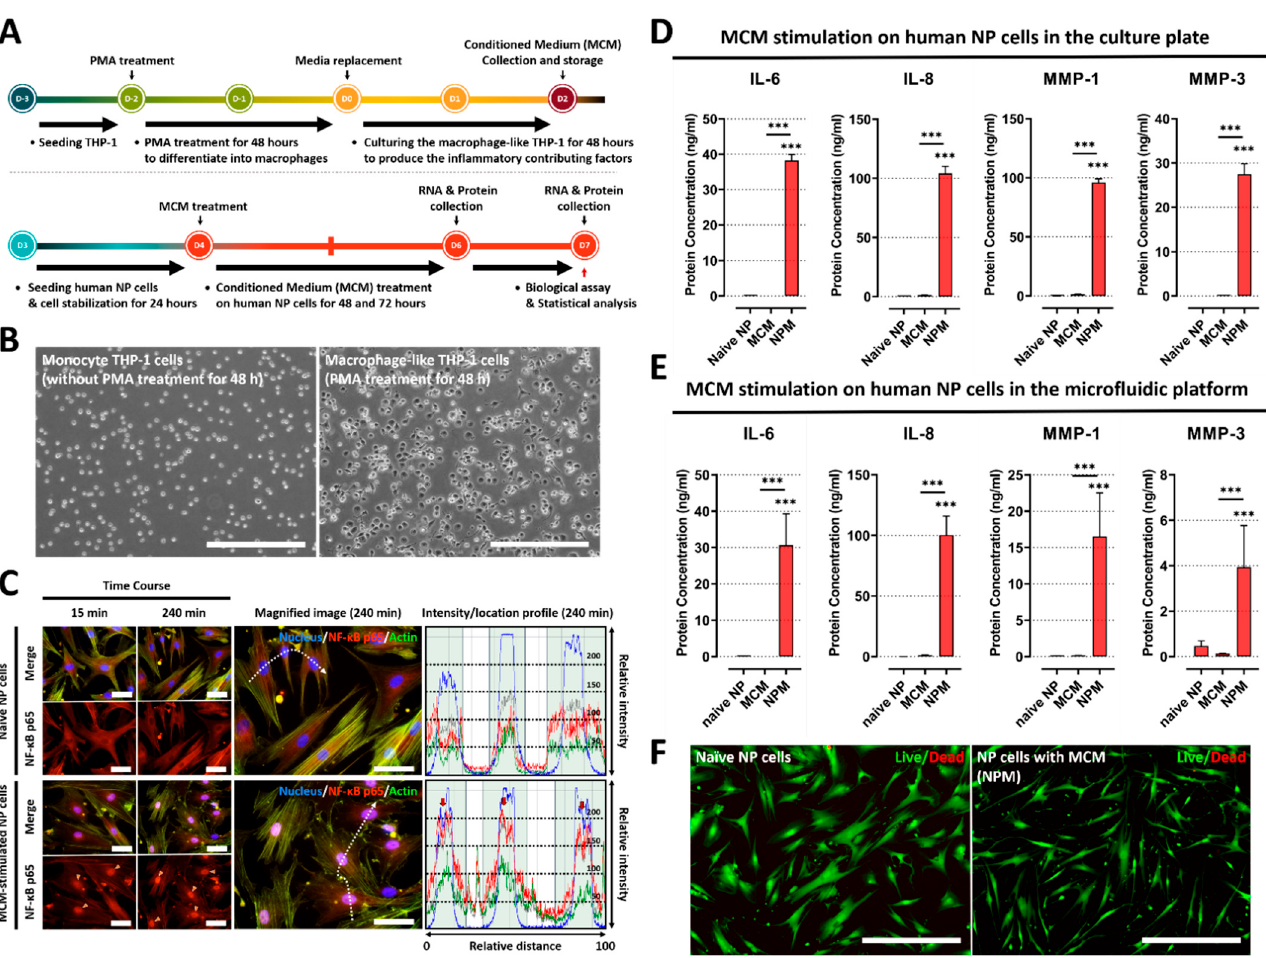
Figure 1. Effects of soluble factors on the culture medium of macrophage THP-1 cells on human NP cells. ( A ) Schematic of experimental timeline for MCM production of and paracrine effect replication on human NP cells stimulated by MCM. ( B ) The images show that human monocyte THP-1 cells differentiate into activated THP-1 macrophages cells upon PMA treatment for 48 h (scale bar = 400 μ m). ( C ) MCM stimulation on human NP cells for degenerative IVD conditions. Fluorescence image and quantification of fluorescence intensity of NF- κ B p65 in human NP cells stimulated by MCM are shown. The NF- κ B p65 protein is preferentially distributed in the nucleus rather than the cyto- plasm (red arrow). This can induce degenerative conditions in human NP cells as the p65 protein acts as a transcription factor (scale bar = 125 μ m). ( D ) The results show that MCM-exposed human NP cells produce inflammatory mediators and ECM-modifying enzymes compared to naïve NP cells or MCM, in both conventional culture plates and ( E ) our microfluidic platform. ( F ) Assessment of human NP cytotoxicity with/without MCM using a live/dead assay. MCM-cultured human NP cells did not exhibit any difference in cell cytotoxicity compared with naïve NP cells (scale bar = 400 μ m). *** p < 0.001 as compared with naïve NP cells. The line indicates comparison with each group.